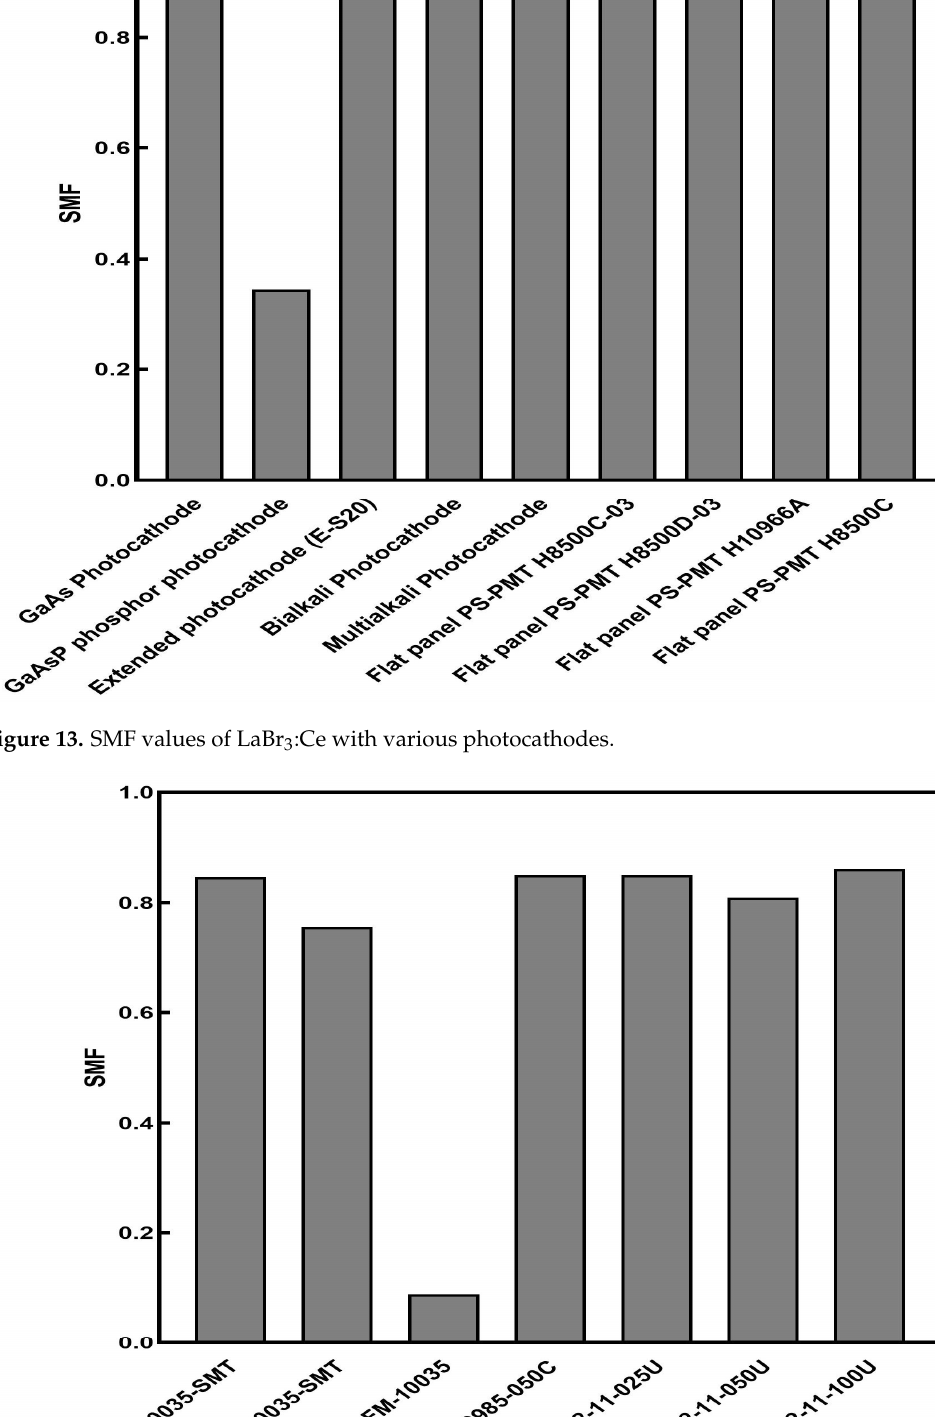
Figure 12. SMF values of LaBr 3 :Ce with various CMOS.